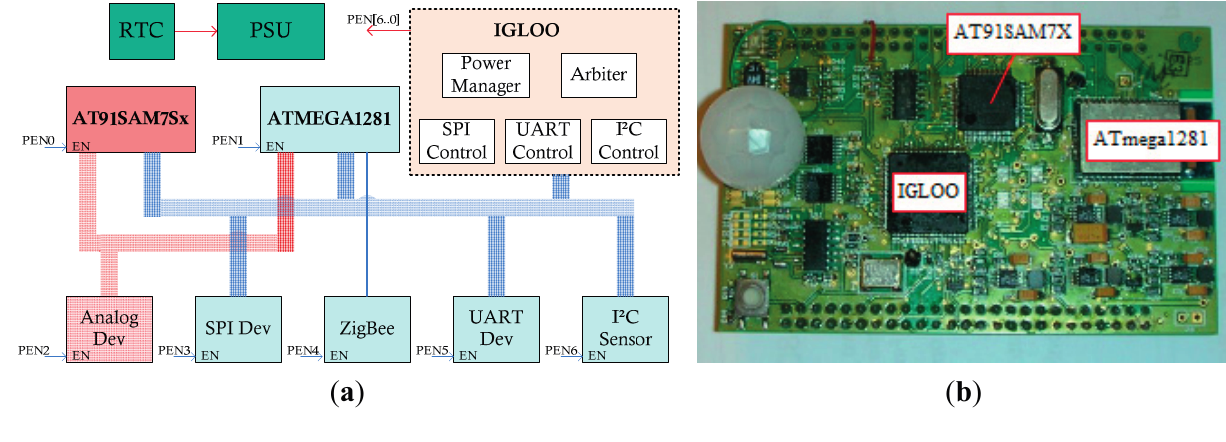
Figure 14. ( a ) Block diagram of the multi-core node EMWSN. ( b ) Prototype board of the multi-core node